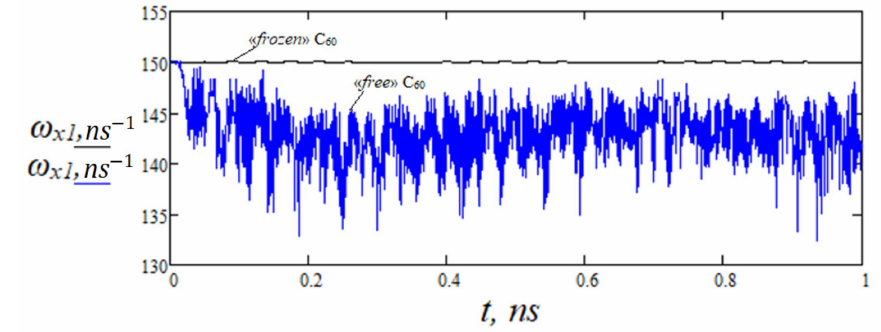
Figure 5. Change in time of the y -component of the angular velocity of the